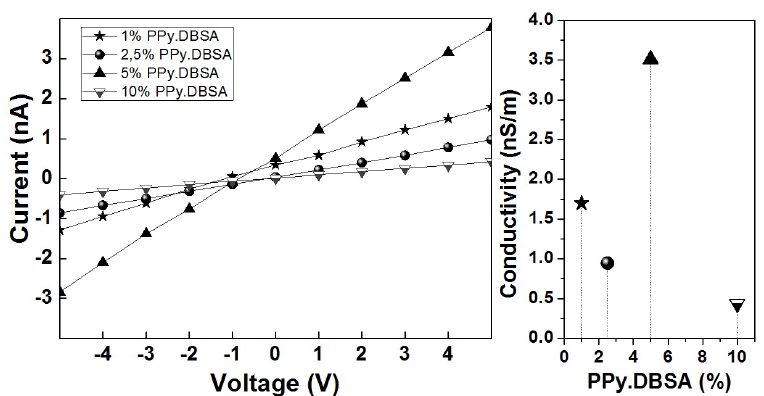
Figure 4. I vs . V characteristic (left) and conductivity curve (right) of the electrodes covered with electrospun PPy.DBSA/PVA nanofibers in different mass proportions of PPy.DBSA, 1%, 2.5%, 5% and